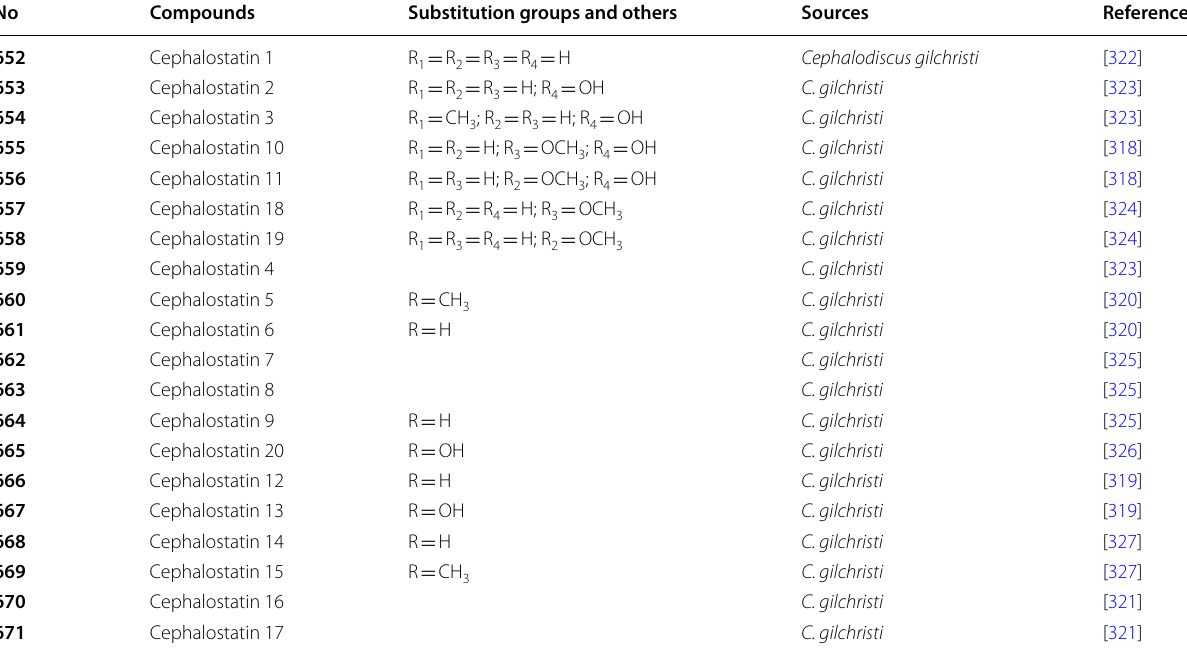
Table 16 Structures and sources of cephalostatins